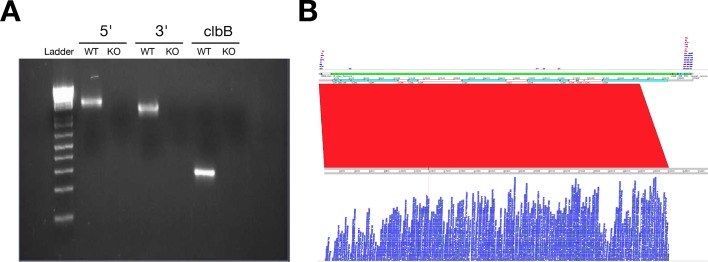
Confirmation of pks island deletion.(A) Representative gel image of PCR reactions from each bacterial strain (E. coli NC101 and E. coli NC101Δ
pks) performed with primers specific for the 5’ or 3’ end of the pks island (product size = 1824 bp or 1413 bp, respectively) or the genotoxin colibactin (clbB) (product size = 280 bp). (B) Screenshot from the Artemis Comparison Tool showing the absence of pks island from E. coli NC101Δ
pks and its presence in E. coli NC101. Reads from NC101Δ
pks were mapped to the pks island region (top panel), where reads only mapped to the flanking region of the pks island region of the reference genome assembly (GenBank Accession number: AM229678.1). Reads from NC101 were mapped to the pks island region (bottom panel), where reads mapped across the entire pks island region of the reference genome assembly. The red band indicates the sequence similarity from the pks island region sequenced from NC101 and the region extracted from the wild type genome reference assembly. Additional details for this experiment can be found at https://osf.io/ye9gh/.